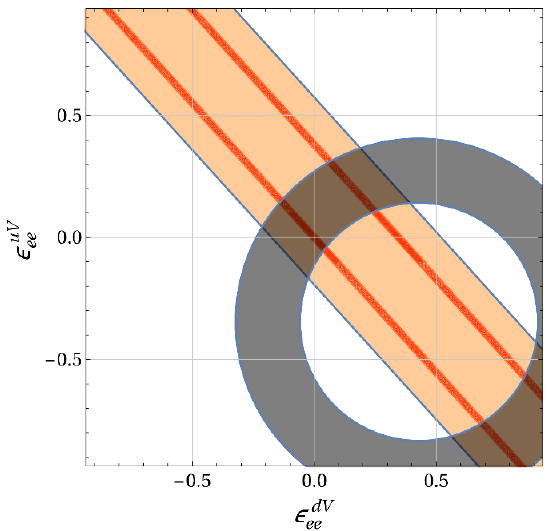
Figure 5 . The regions allowed at 90% C.L. for electron neutrino NSI with vector up and down quark currents (1.1). The black, orange and red regions correspond to CHARM, COHERENT and expected NaI 2T constraints, respectively, see text for